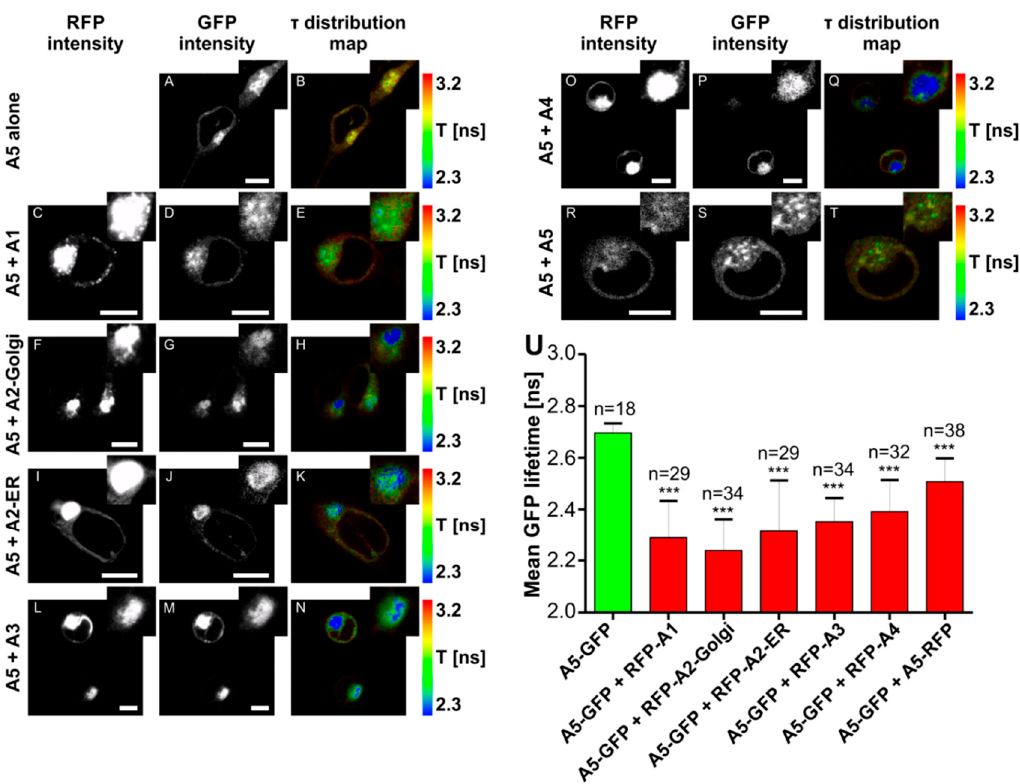
Figure 8. In vivo fluorescence lifetime imaging microscopy (FLIM)/Förster resonance energy transfer (FRET) analysis of interactions between the SLC35A5 protein and other members of the SLC35A subfamily. ( A – T ) Confocal intensity-resolved ( A , C , D , F , G , I , J , L , M , O , P , R , S ) and time-resolved ( B , E , H , K , N , Q , T ) images of A5/enhanced GFP (eGFP) ( D , G , J , M , P , S ) interaction with monomeric red fluorescence protein (mRFP)/SLC35A proteins ( C , F , I , L , O , R ) in HEK293T cells in comparison with cells expressing A5/eGFP only ( A ). Red-to-blue color shift reflects a shortening of the fluorescence lifetime. The rainbow scale bar placed next to the time-resolved images ( B , E , H , K , N , Q , T ) represents the fluorescence lifetime range between 2.3 (blue) and 3.2 (red) ns. Scale bar = 10 µm; τ —fluorescence lifetime. ( U ) Mean eGFP lifetime values in the absence and in the presence of the acceptor are shown. Data are presented as means ± SD from several measurements of the indicated cell number ( n ). *** p ≤ 0.001.